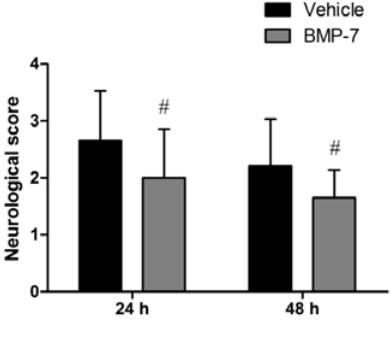
Figure 1. Bone morphogenetic protein-7 (BMP-7) significantly improved neurological recovery compared with the vehicle group at 24 or 48 h after reperfusion. Data were expressed as mean ± SD ( n = 20); # p < 0.05 versus vehicle